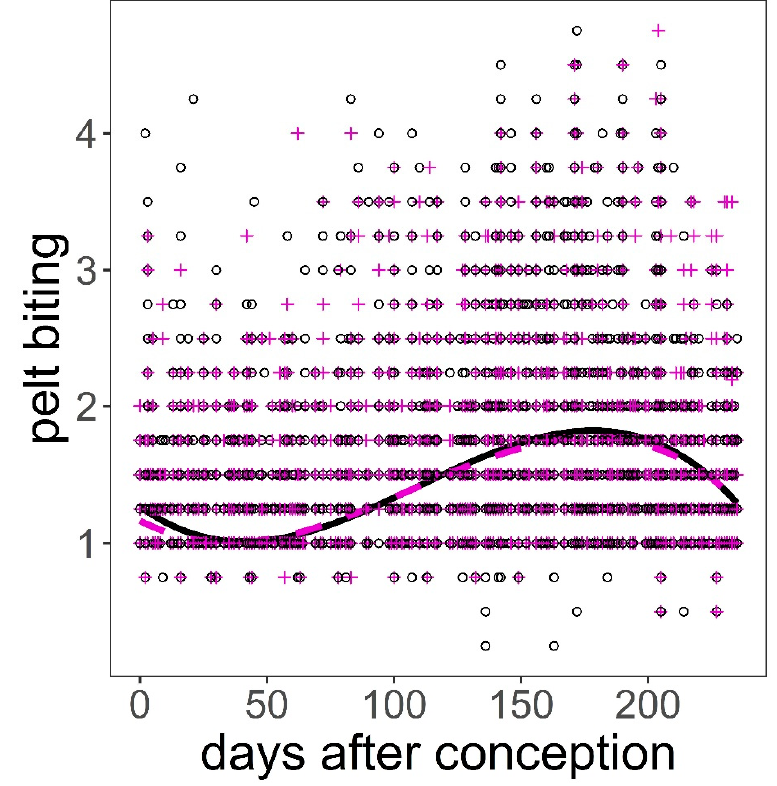
Figure 6. Predictions on the response of pelt biting on red deer hind to days after conception controlling for hind age and hind weight using model in Table 5. Black continuous line and black open circles are hinds carrying male foetuses; magenta dashed line and magenta crosses are hinds carrying female foetuses. Variables not present in the plots were fixed to their means.